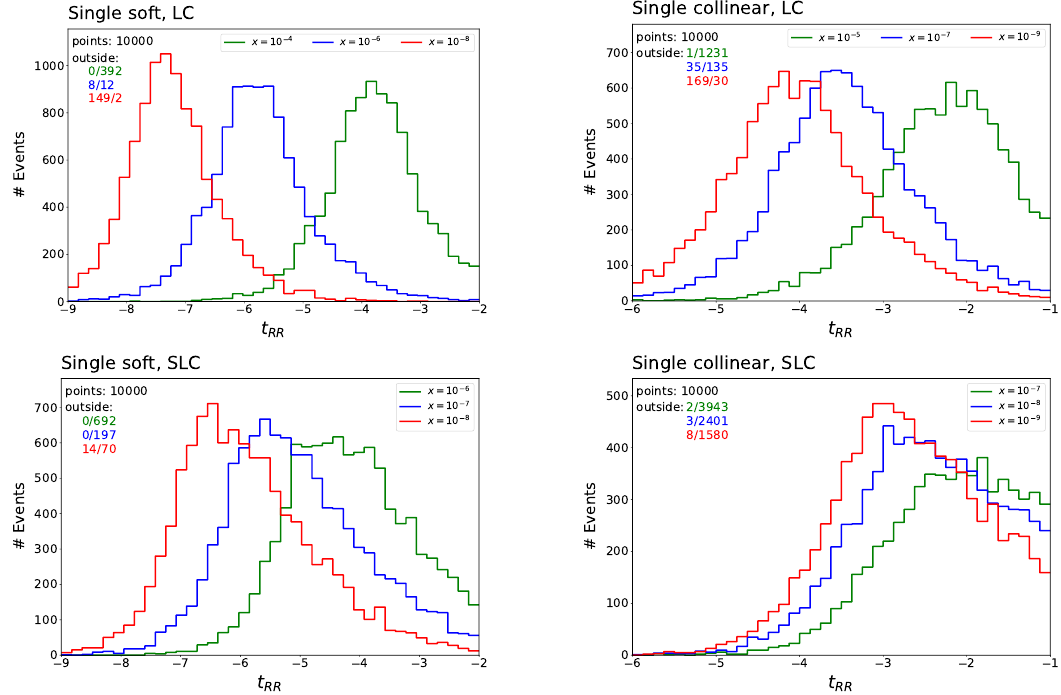
Figure 5 . Test of the double real subtraction term in single soft (left) and single collinear (right) limits for the leading colour (upper plots) and subleading colour (lower plots)